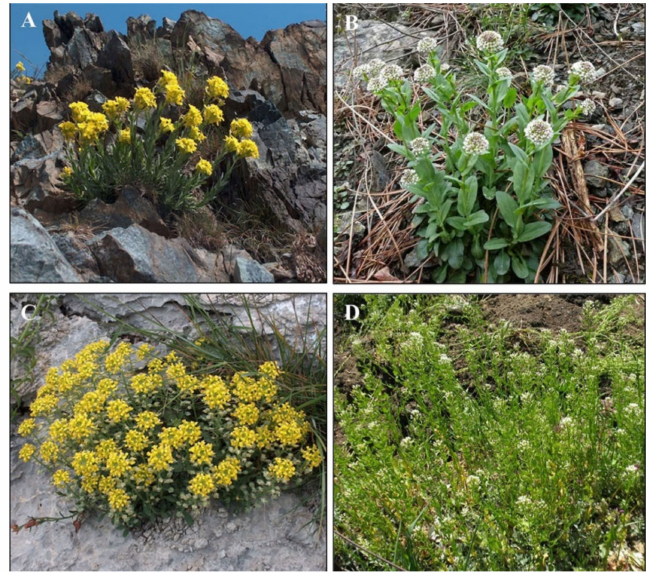
Figure 5. Test species: Ni-hyperaccumulator ( A ) A. utriculata and ( B ) N. caerulescens and non- hyperaccumulator ( C ) A. montanum and ( D ) T. arvense, photographs by S. Marsili ( A , C ), N. Mazzoni ( B ), G. Nicolella ( D